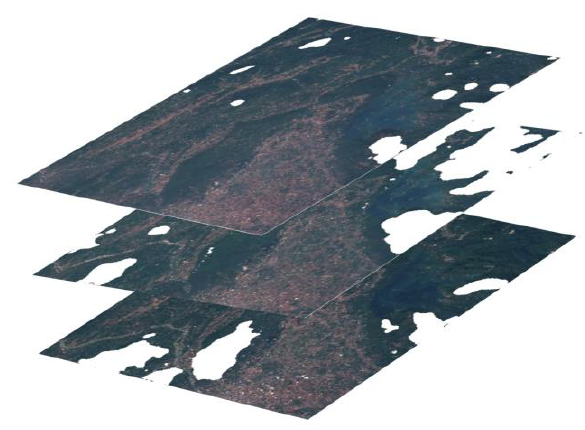
Figure 5: Stacked previews with cloud masks used to compile a minimum scene list.